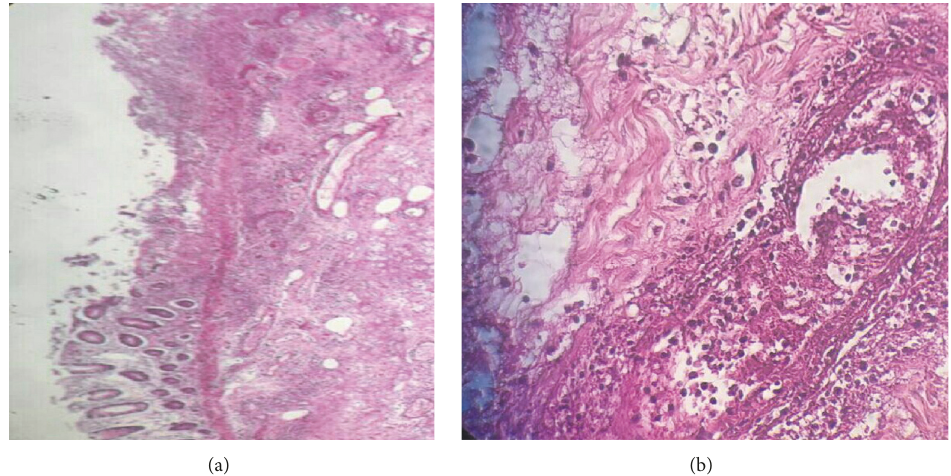
Figure 2: Pathology assessment. (a) Necrotizing inflammation of the mucosa and submucosa. (b) Necrotizing